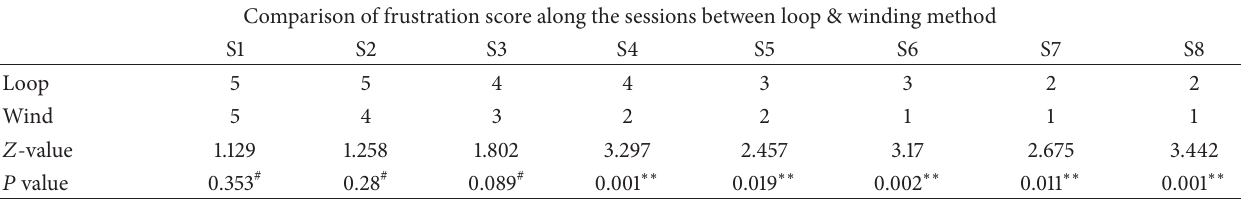
Table3:ComparisonoffrustrationlevelattheendofeverysessionwasdonebetweengroupsAandB(from1,leastfrustration,to5,maximum frustration).